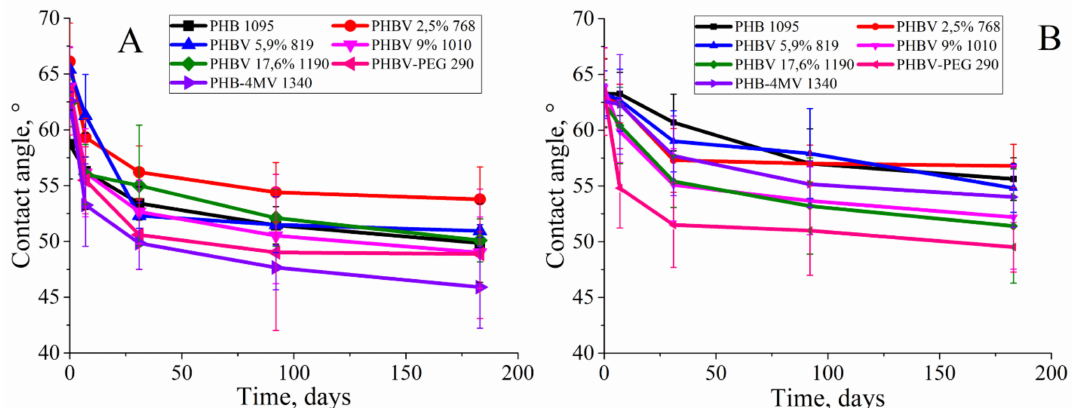
Figure 8. The changes of the contact angle at the water / film boundary of a PHA with a di ff erent HV molar content in the PHB chain during enzymatic degradation ( A ) and hydrolytic degradation ( B ) for 6